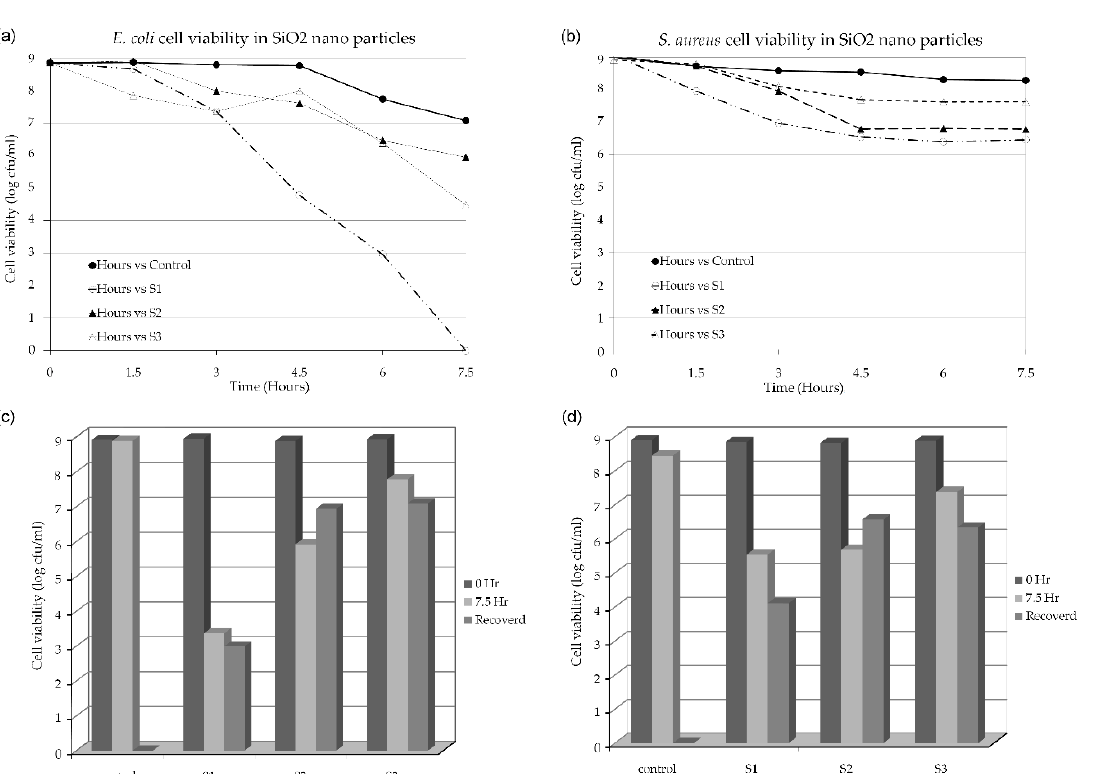
Figure 5. Bacterial cell viability under the treatment of S1, S2, and S3 nanopowders compared with control (without treatment); ( a ) E. coli and ( b ) S. aureus . Viable cell count after the treatment of culture for 7.5 h by S1, S2, and S3 nanopowders recovered via sonication and comparison with control (without treatment); ( c ) E. coli and ( d ) S. aureus .